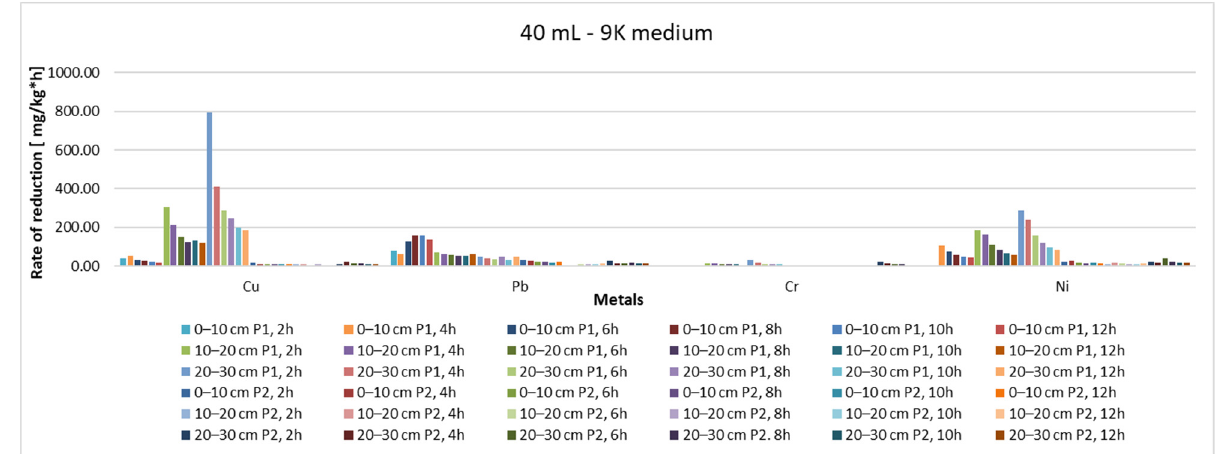
Figure 14. Reduction rate of pollutant concentration, depending on sample, sampling depth, amount of 9K medium and extraction time (40 mL 9K medium).